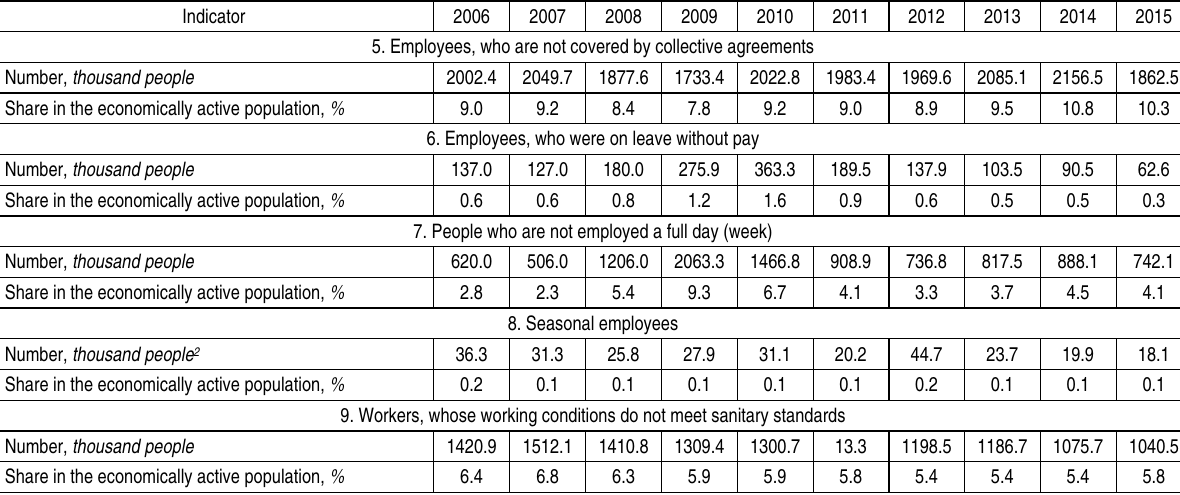
Table 1 (cont.). Indicators characterizing the categories of economically active population of Ukraine in the status of precariat in